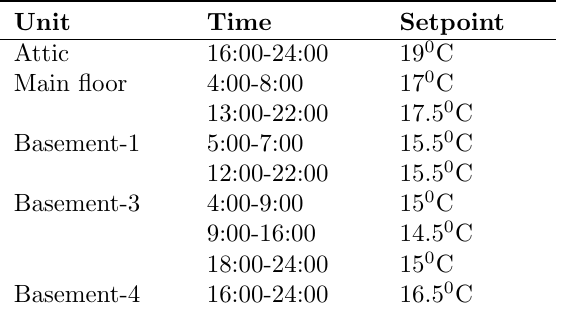
Table 4: Temperature setpoints for each unit of the building based on the time of the day